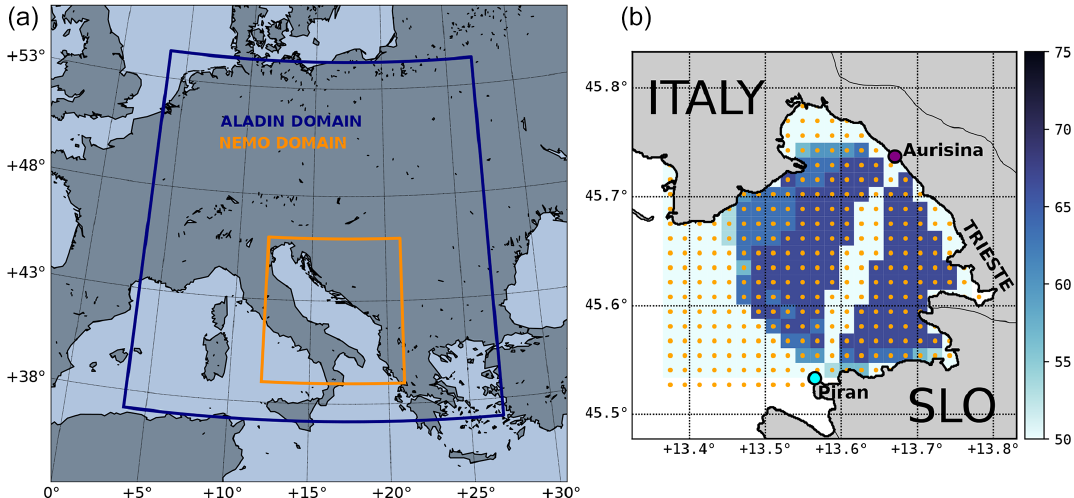
Figure 3. (a) Computational domains of ALADIN SI (blue) and NEMO (orange) numerical models. (b) WERA HF radar grid (orange dots) and data availability percentage per grid point between 29 October 2018 16:00UTC and 30 October 2018